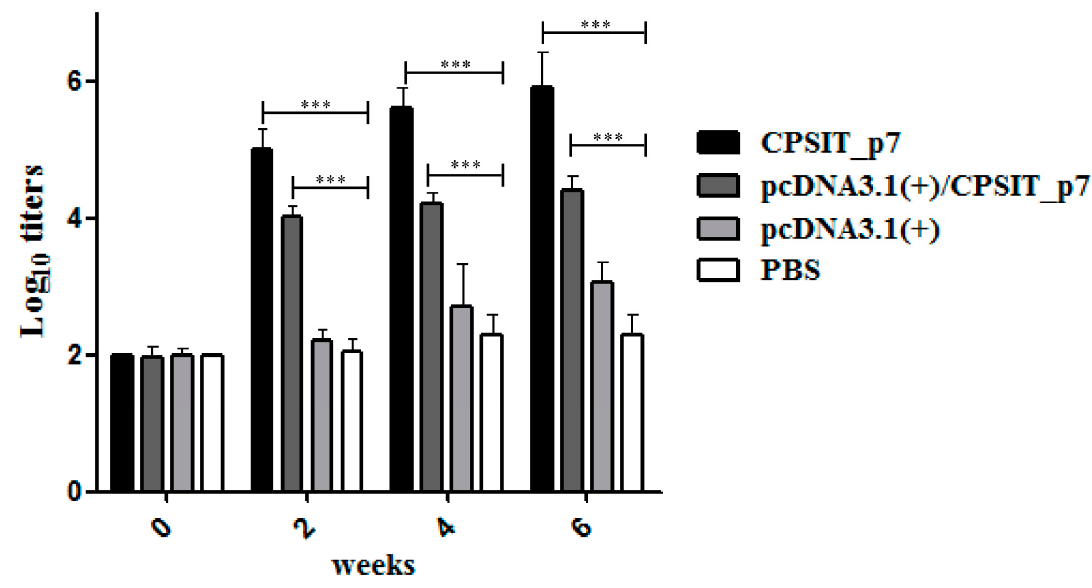
Figure 2. ELISA showing the antibody levels in the mice immunized with different vaccines. Mice were intramuscularly immunized three times at 2-week intervals with 100 µ g of the pcDNA3.1(+)/CPSIT_p7 plasmid, 100 µ g of pcDNA3.1(+) vector, 30 µ g of recombinant CPSIT_p7 protein, or 100 µ L PBS, respectively. Serum samples were collected, and the levels of serum IgG were analyzed by ELISA. The means and standard derivations for the antibody levels were calculated from five mice. *** p < 0.001.